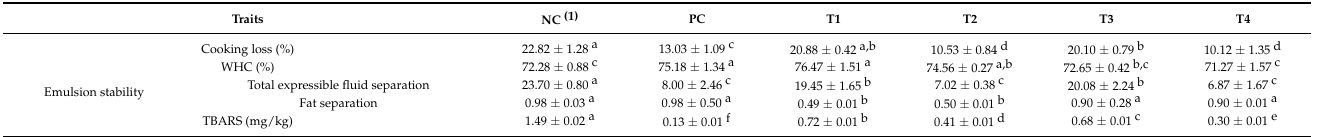
Table 4. Effects of grafted insect protein and eggshell powder on cooking loss, water holding capacity (WHC), emulsion stability, and thiobarbituric acid reactive substances (TBARS) of phosphate free meat emulsion.